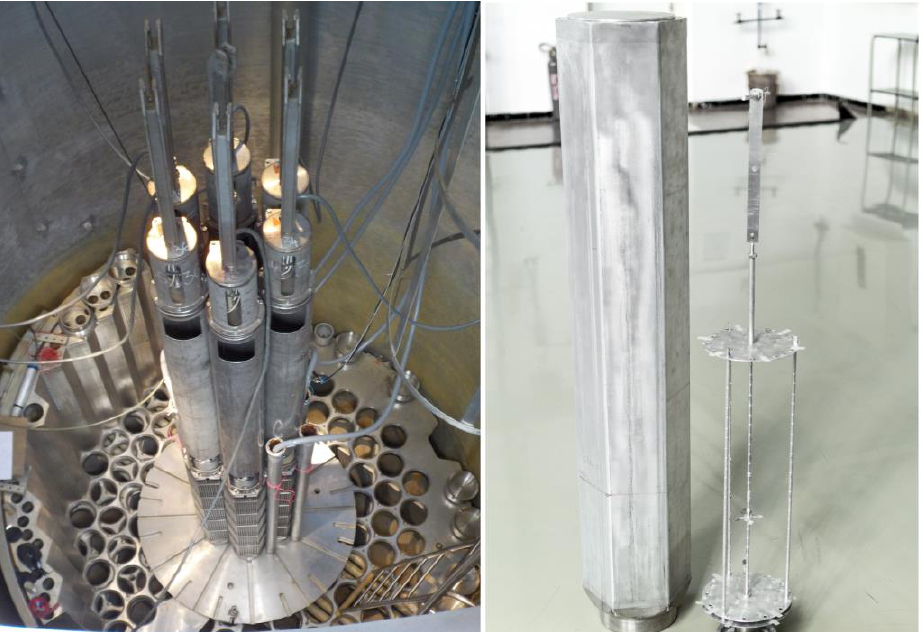
Figure 1. Overhead view inside the LR-0 reactor with special core without moderator (left) and view on dry assembly and used holder of activation detectors